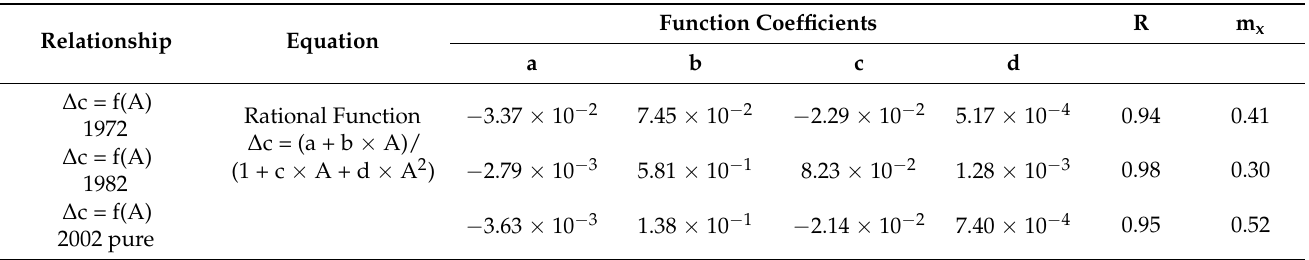
Table 1. Parameters of regression models identifying the relationship between the average stock increment and the age of aspen